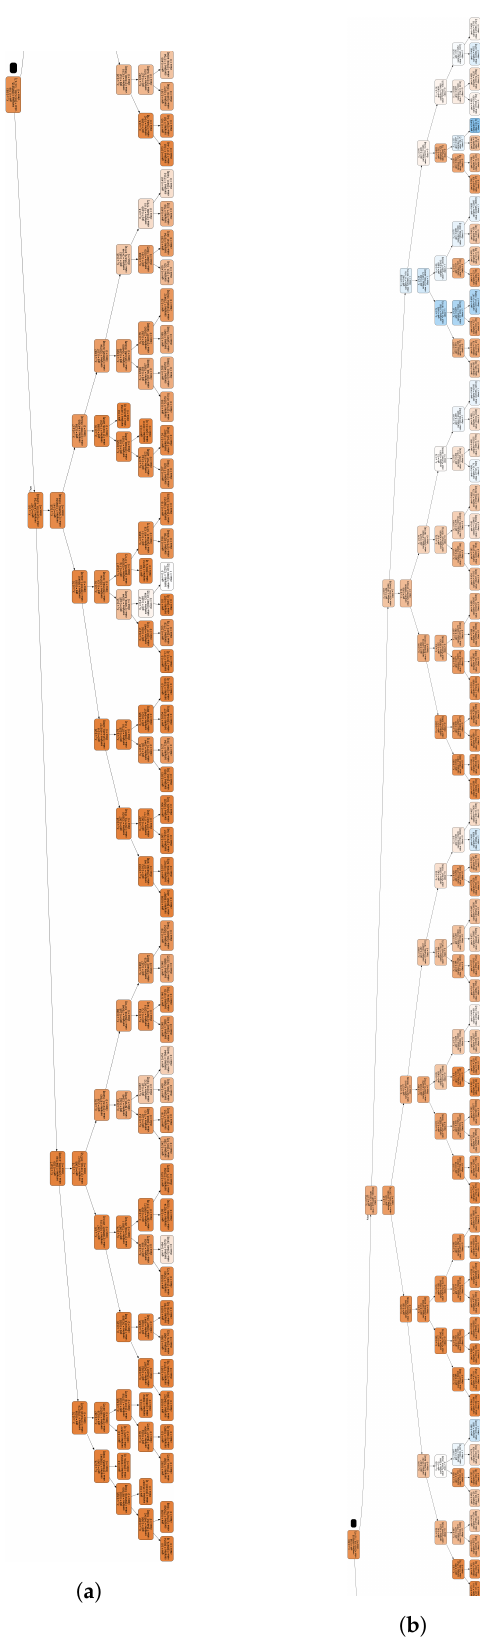
Figure 5. Graphs of decision tree (DT) models for ( a , b ) horizontal TT (TT _H), ( c , d ) vertial TT (TT _V) with a left and right by root node,